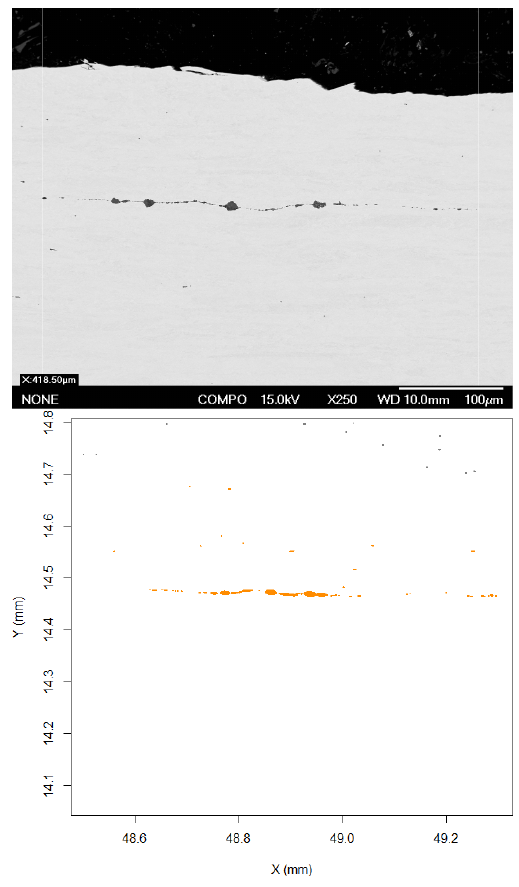
Figure 10: A long inclusion cluster as shown in the SEM specimen and as shown in the